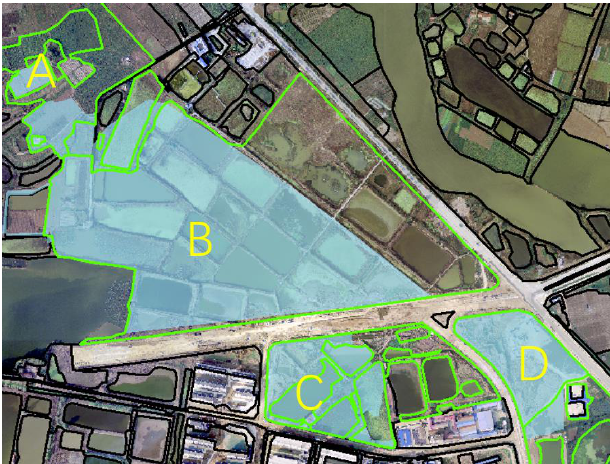
Figure 3. A demonstration of a change map at pixel, polygon and object level. The translucent blue masks show changes at the pixel level. The black borderline polygons are the unchanged regions; the 14 green polygons overlap with the changed pixels exceeding a certain overlapping percent are the changed polygons. Those connected change pixels in the pixel-based map are grouped into a changed “object”. There are A, B, C and D four patches changed at the object